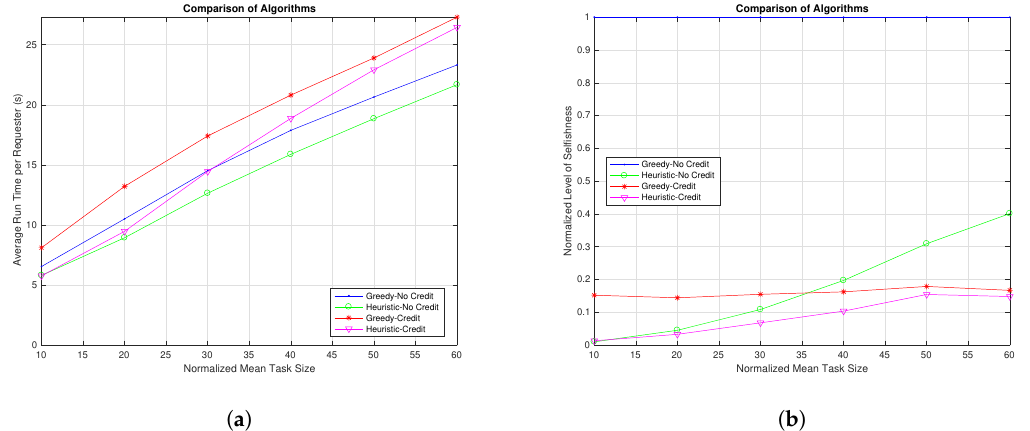
Figure 7. Effect of mean task size. ( a ) Effect on average task execution time; ( b ) effect on the level of selfishness.